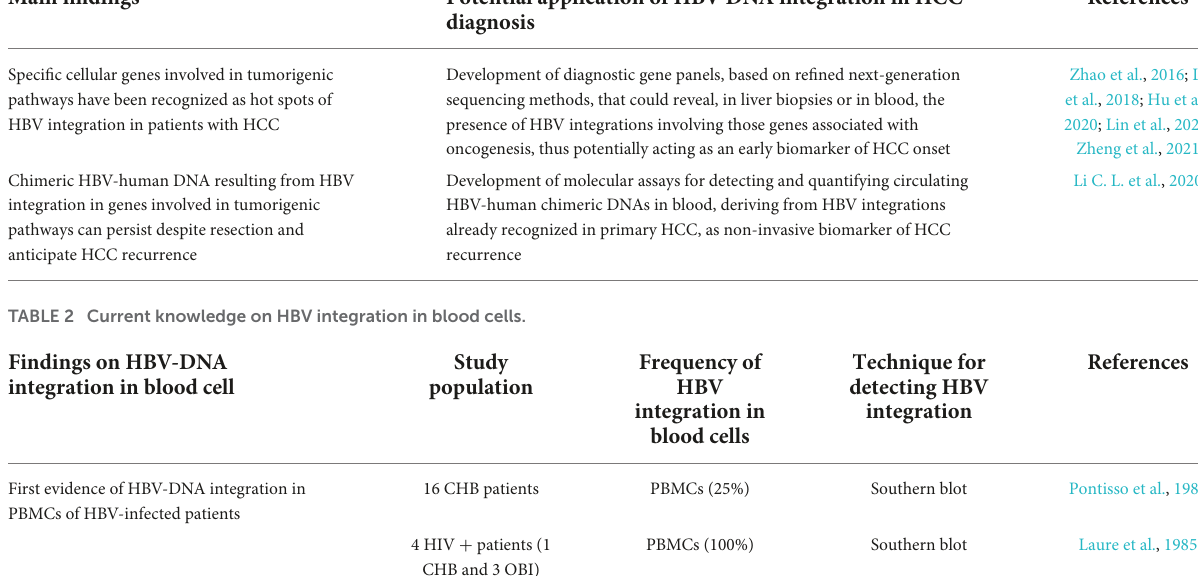
TABLE 1 Diagnostic application of HBV-DNA integration as a novel biomarker for HCC occurrence and recurrence. Main findings